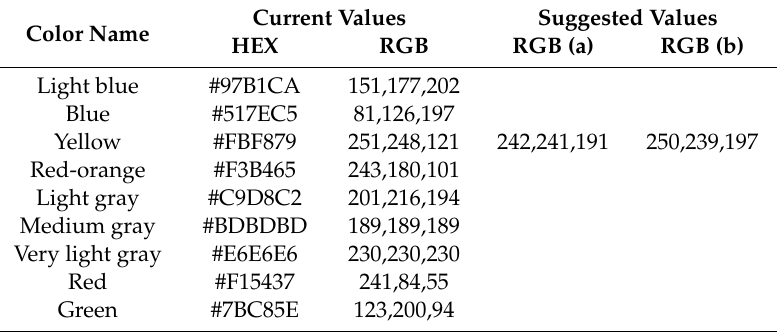
Table A4. Wikimapia colors